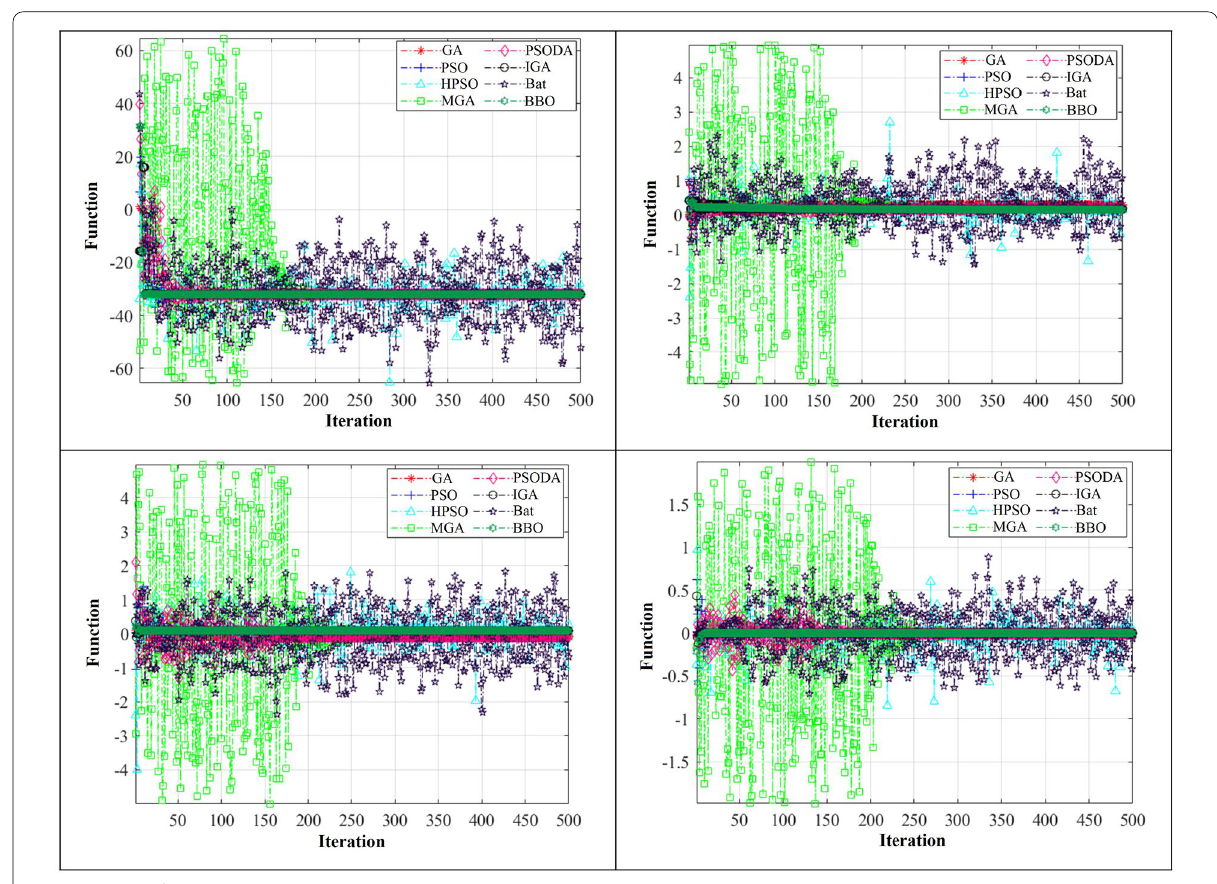
Fig. 9 indicates the average fitness of different